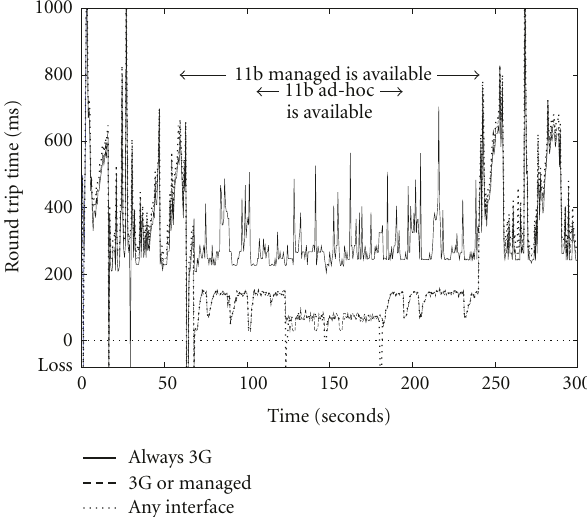
Figure 15: Evolution of the throughput of three TCP flows between MNNs using routing policies.